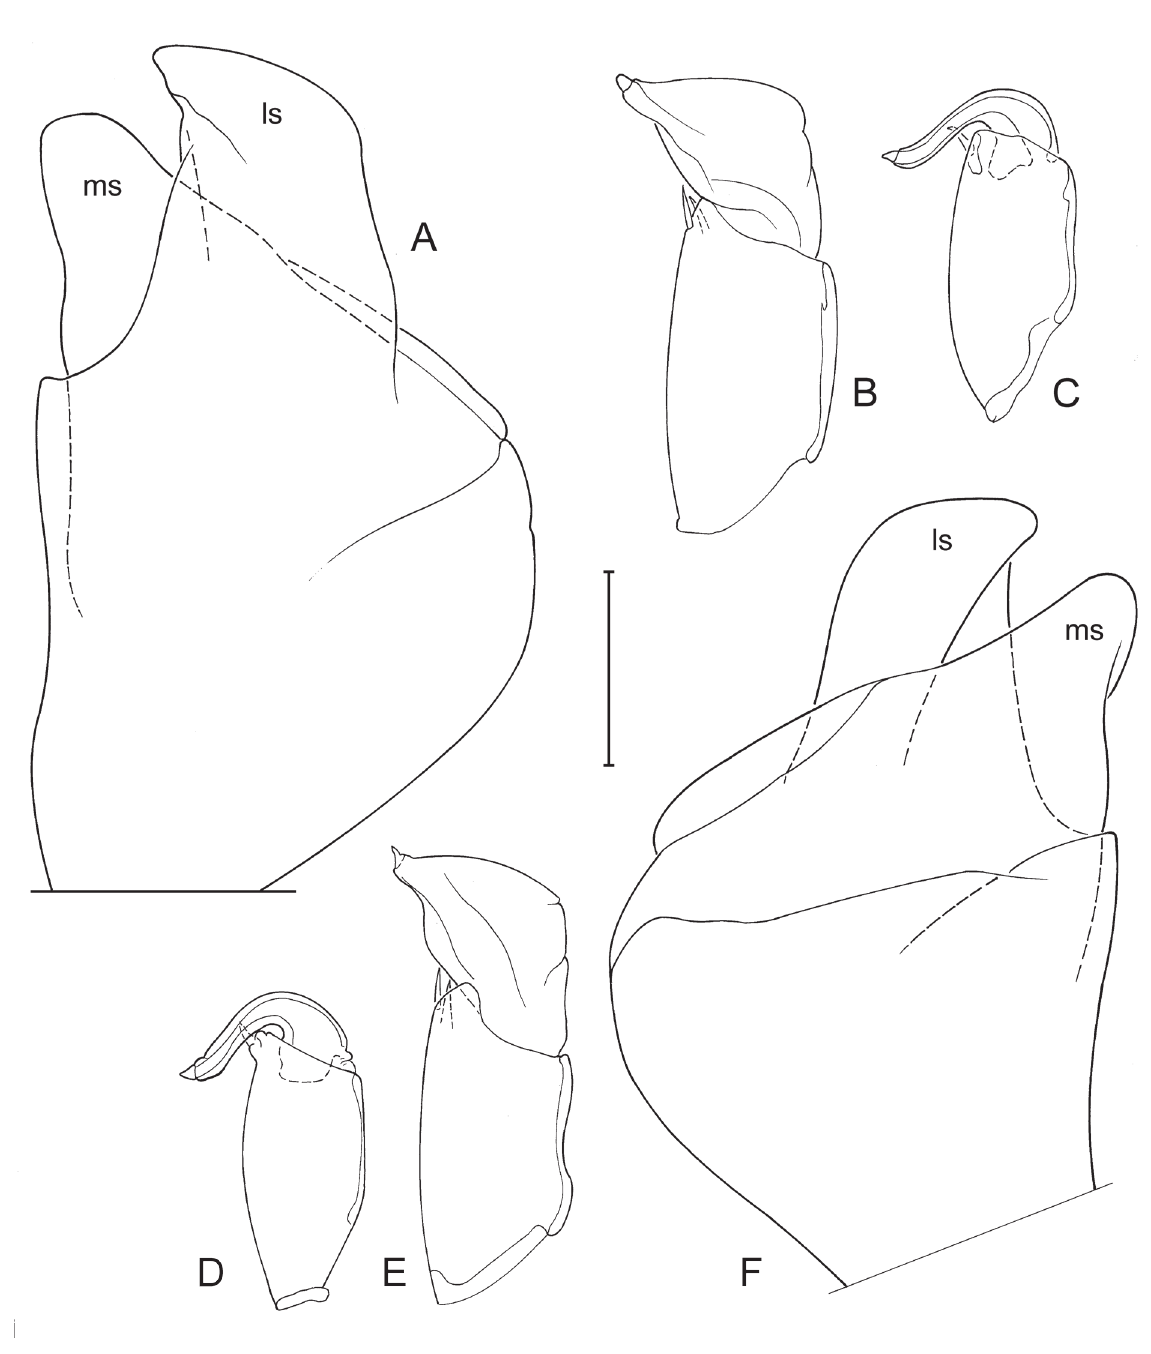
Fig. 9. Bennelongia timmsi sp. nov., paratypes from type locality (Wave rock, BVt/10/05). — A-C . Paratype ♂ (WAMC52231): A . Hemipenis (both hemipenes symmetrical in this specimen). B . right prehensile palp. C . left prehensile palp. — D-F . Paratype ♂ (WAMC52230): D . left prehensile palp. E . right prehensile palp. F . Hemipenis (both hemipenes symmetrical in this specimen). scale: a-F= 92